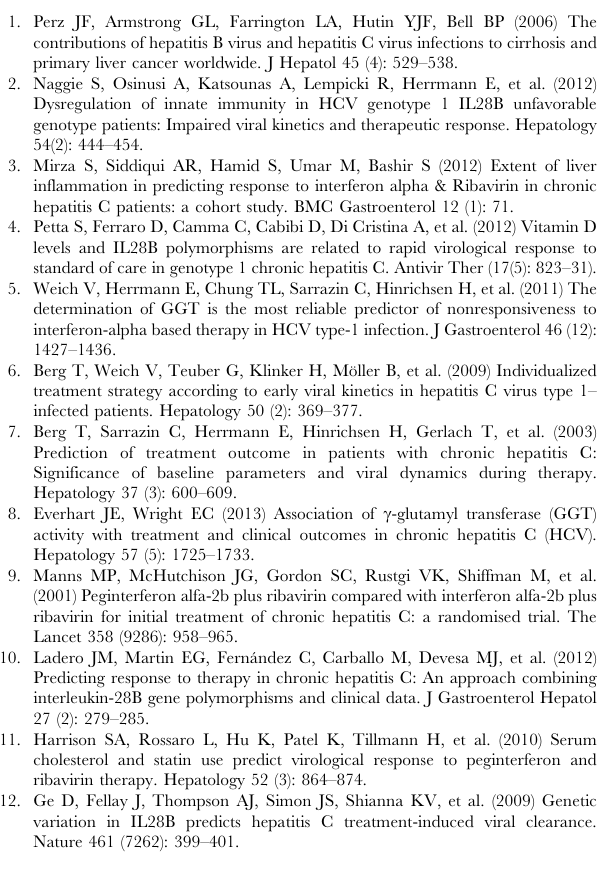
Figure 4. Impact of the GGT/ALT ratio on sustained virologic response (SVR ) according to the IFNL3 polymorphisms. GGT/ALT affects responsiveness of IFNL3 ( A ) rs12979860 and ( B ) rs8099917 and the combination ( C ) rs12979860/rs8099917 in the overall cohort (n=1402); depicted as single values with linear regression curves. The dashed line indicates the normal GGT/ALT ratio.